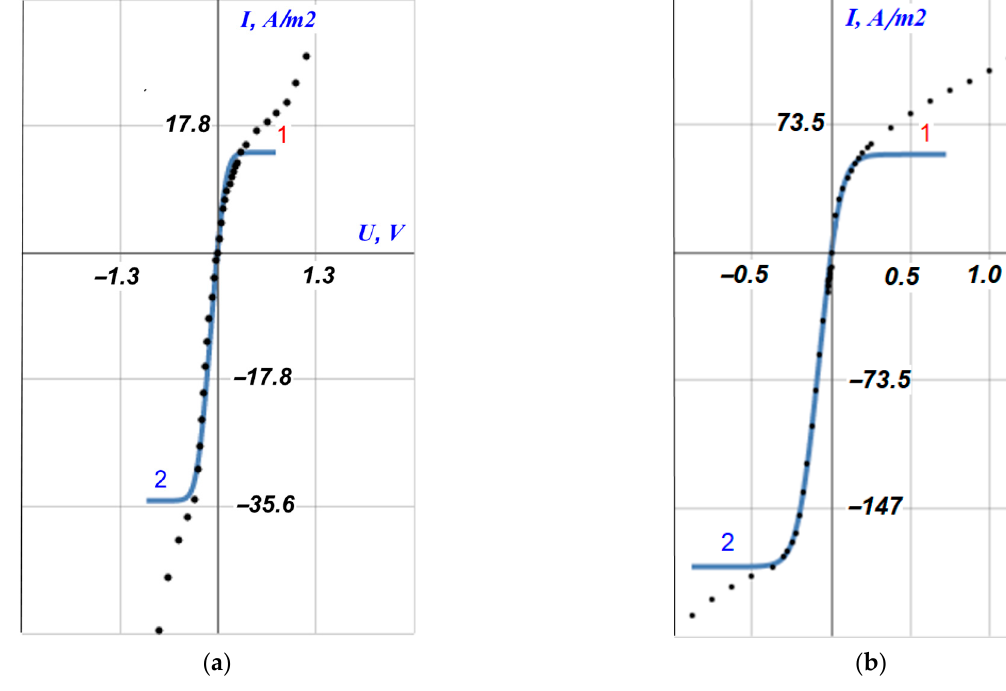
Figure 5. Asymmetrical current–voltage curves of bilayer composite membrane MF-4SC/PTMSP in 0.05 M solution of NaCl ( a ) and HCl ( b ): 1, s—orientation of the layer 1 (PTMSP) of the composite to the anode (towards the counter-ion flux); 2, w—orientation of the layer 2 (MF-4SC) of the composite to the anode; points—experiment; curves—theory.